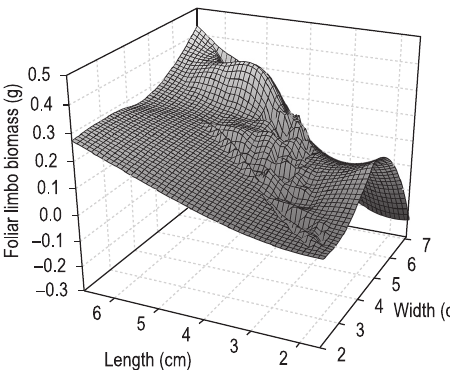
Figure 1. Graphic representation from the width x length x biomass for the foliar limbo biomass.